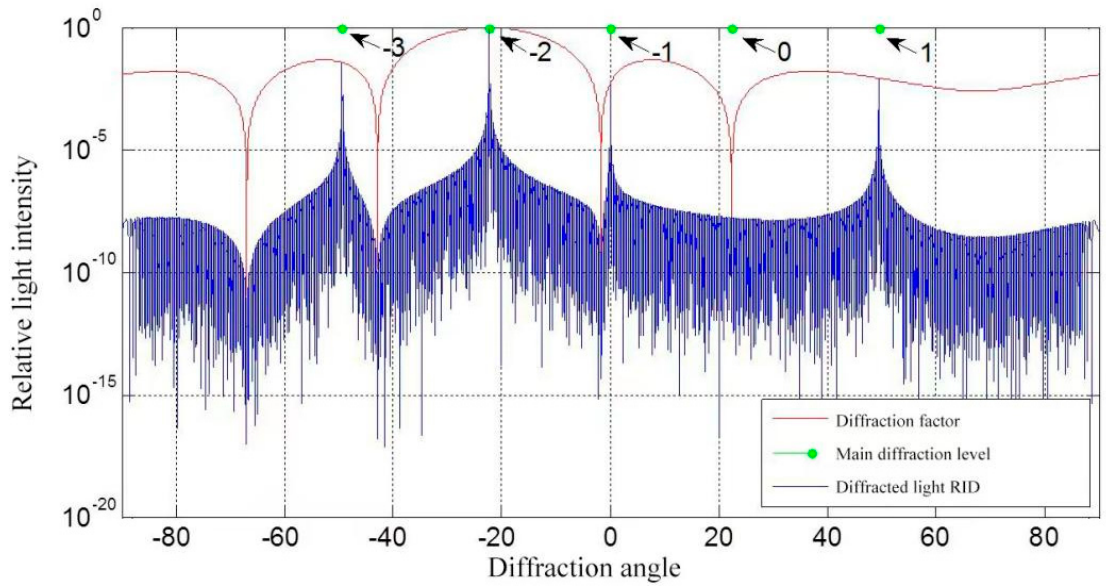
Figure 3. The relative intensity distribution of diffracted light. According to Figure 3, it can be observed that the diffraction grating has five levels of − 3, − 2, − 1, 0, and 1. Among them, level 0 is just eliminated due to the superposition of the maximal value of the interference factor and the minimal value of the diffraction